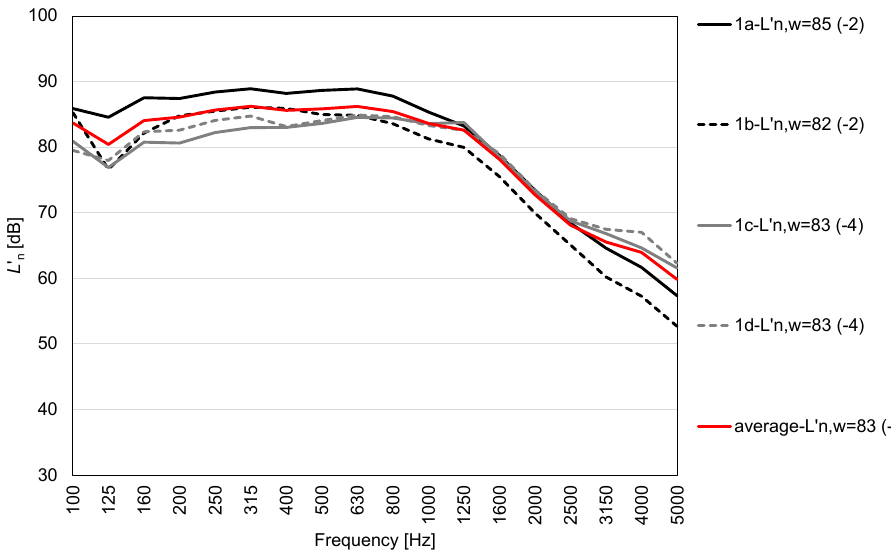
Figure 8. In situ measurements of normalized impact sound pressure level (tapping machine) for four bare CLT floors (configuration 1).